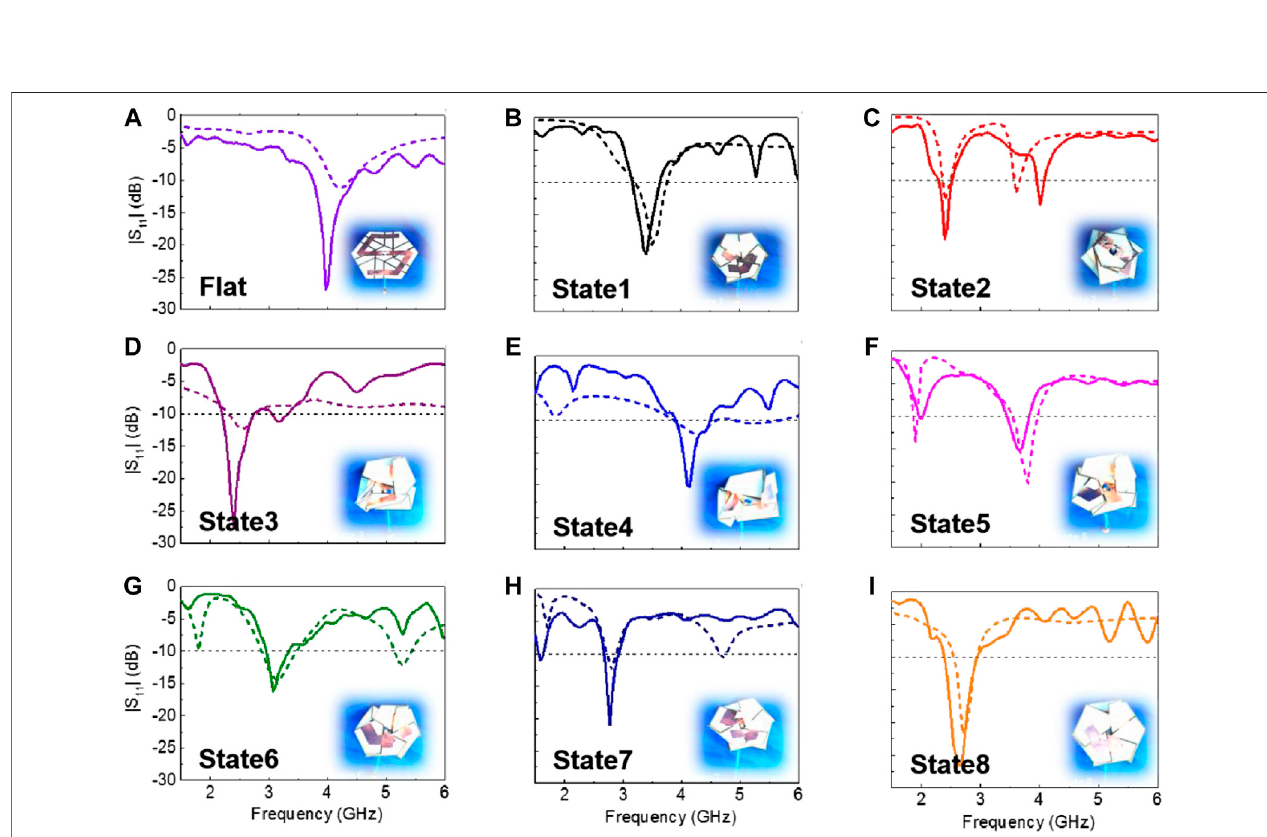
FIGURE10 | The results ofhexagon-twist origami antenna return loss. (A – I) Comparison ofmeasured and simulated results ofantenna returnloss innine different stable state for hexagon-twist origami structure. The corresponding stable state con fi gurations are shown in the illustration.